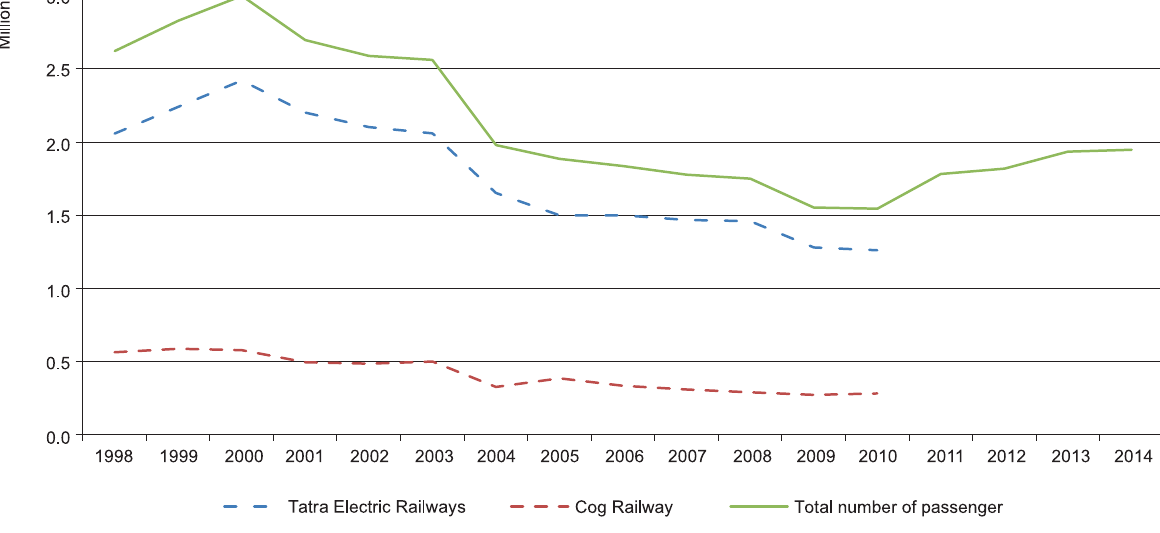
Fig. 9. Number of passengers on the Tatra Electric Railways and on the Tatranská Štrba – Štrbské Pleso Cog Railway. Source: own elaboration based on data from ZSSK – Railway Company